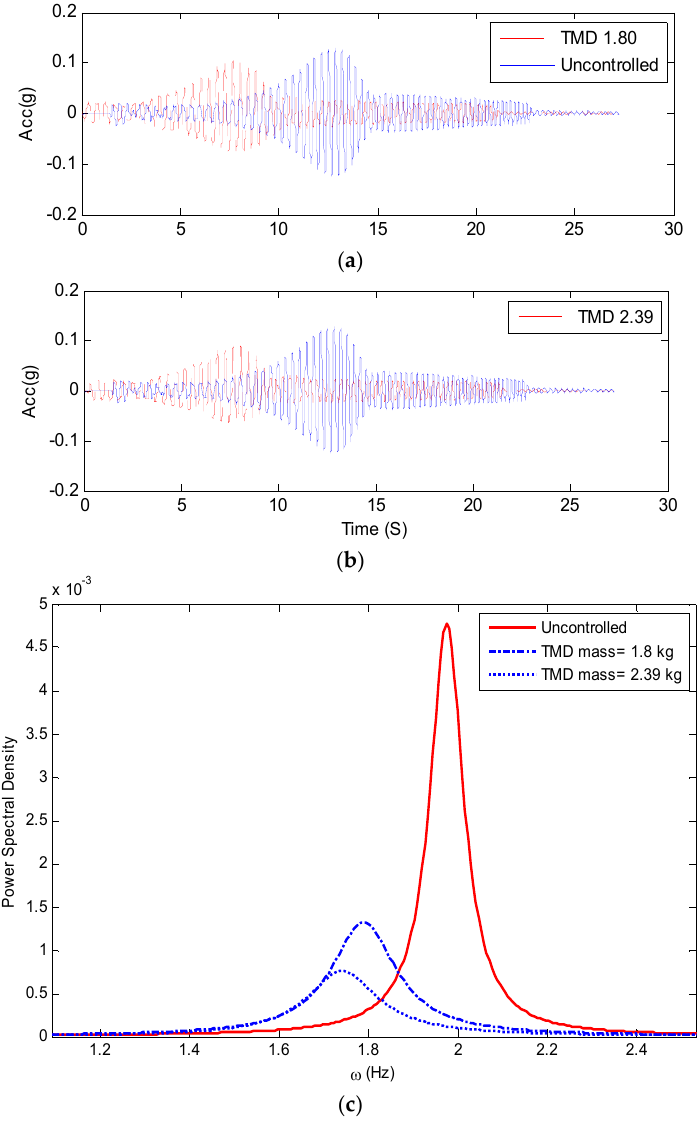
Figure 6. ( a , b ) Structural responses for TMD 1.80 and 2.39 kg of uncontrolled and controlled structure behaviors; and ( c ) frequency contents of output measurements.